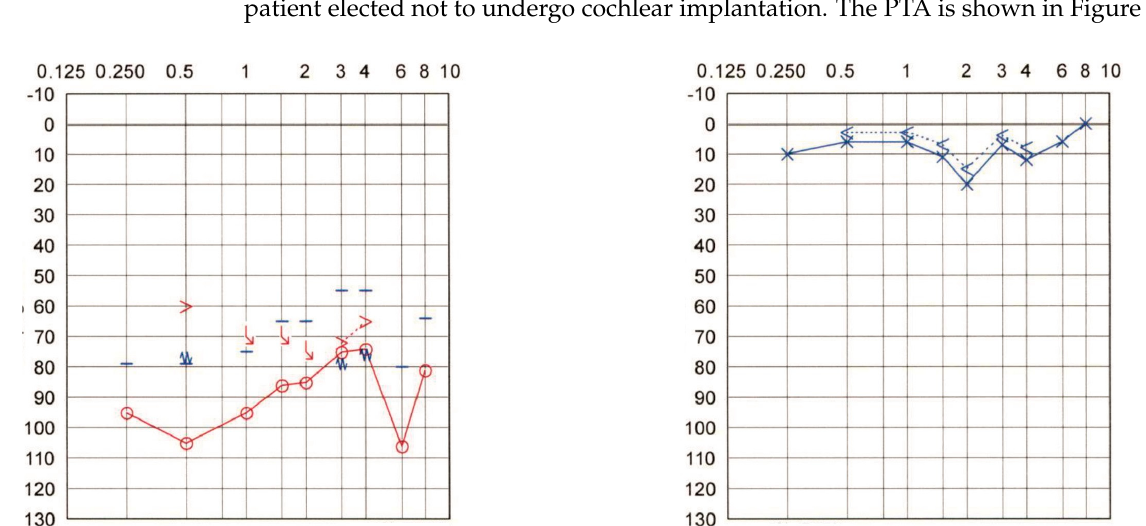
Patient #7: 56-year-old woman who suffered from an acute episode of right-sided